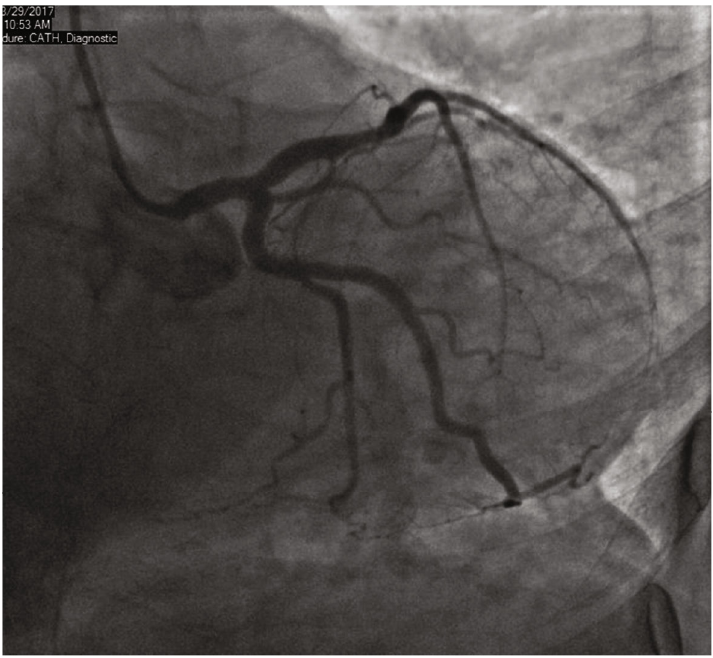
Figure 2: Coronary angiogram showing LAD caudal